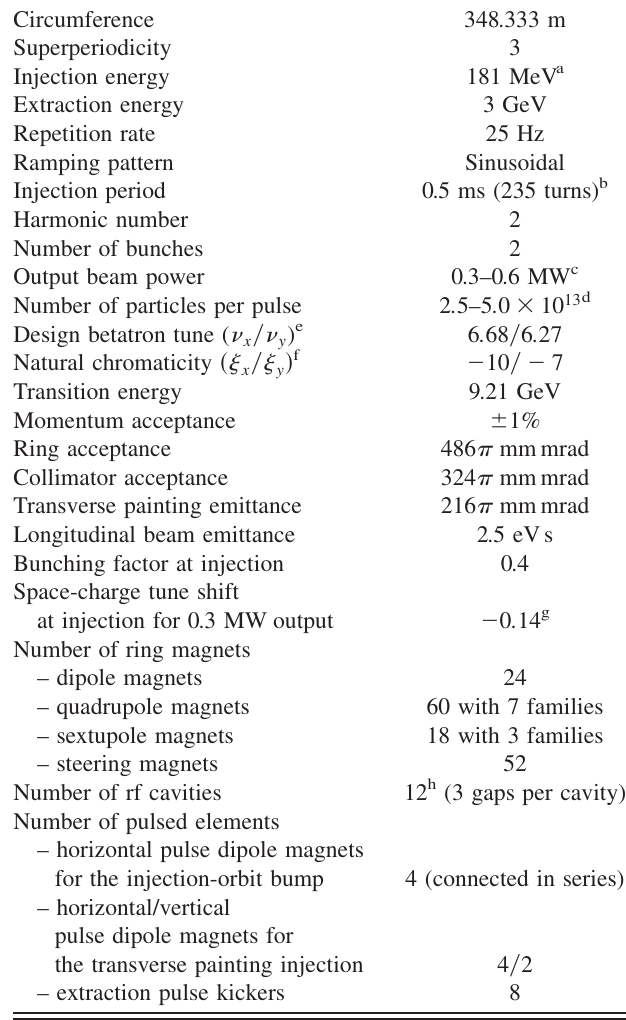
TABLE I. RCS design parameters.